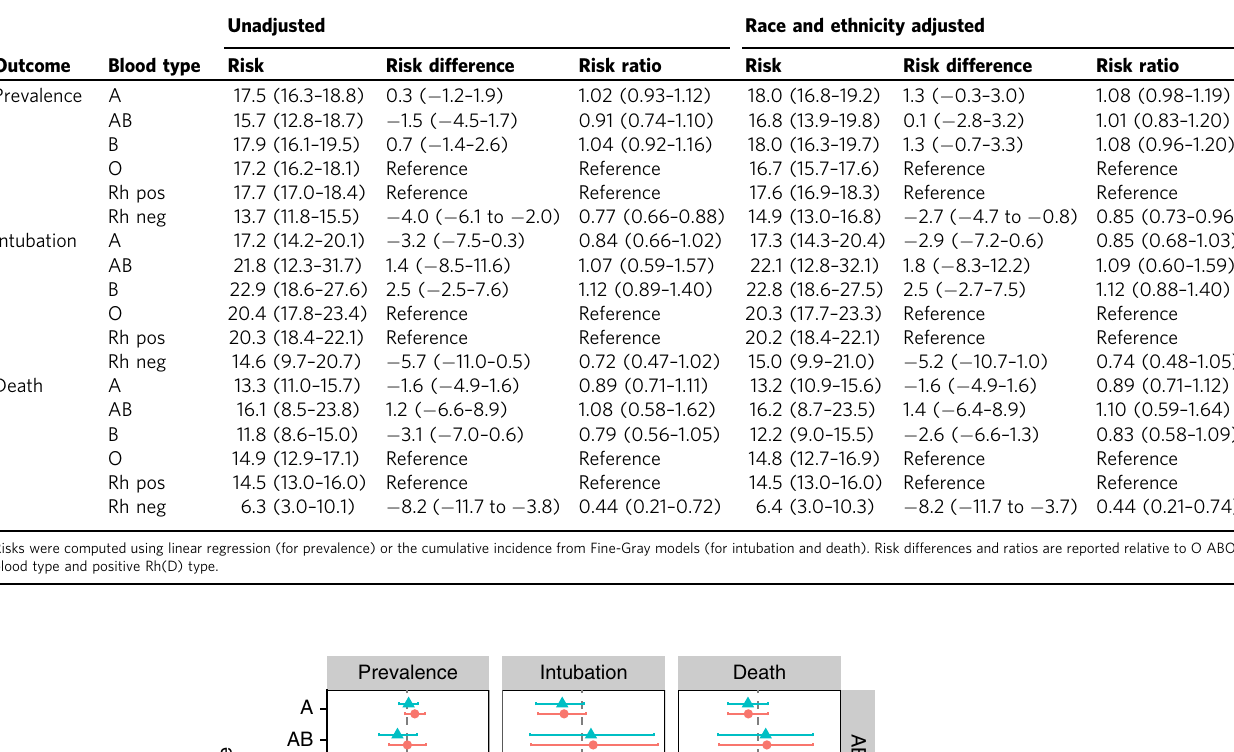
Table 2 Effect size estimates for blood types with and without correction for race and ethnicity.